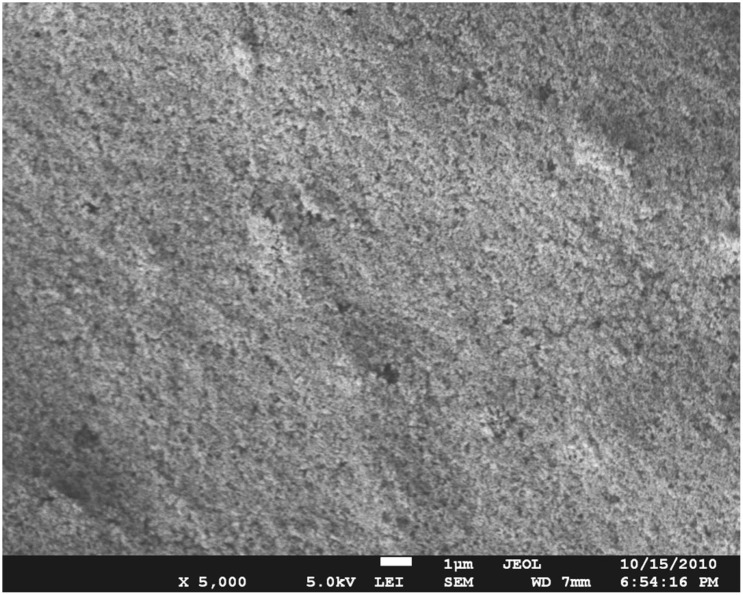
SEM morphology of CuS-GeO2-TiO2 composite coating.